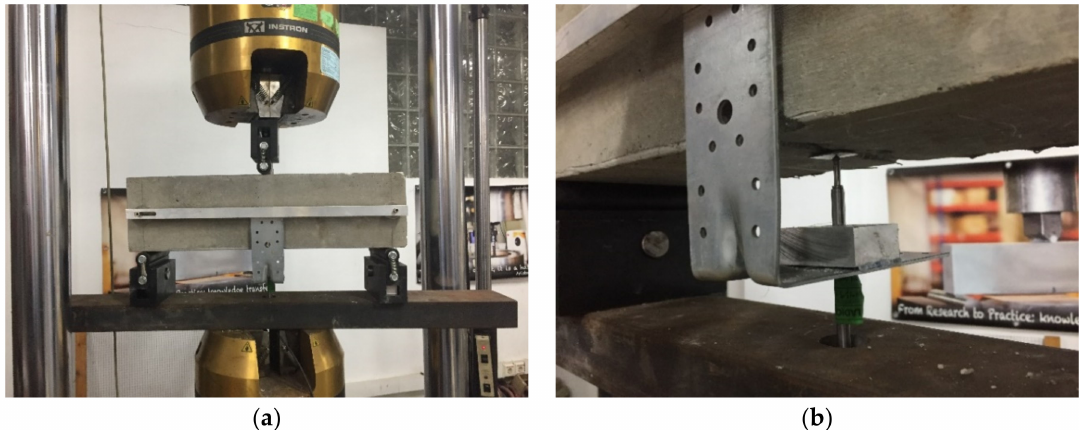
Figure 3. Flexural tensile strength test ( a ) and measurement of vertical displacement with a LVDT ( b ). To measure the CMOD a COD extensometer was used. Two metal pieces were fixed